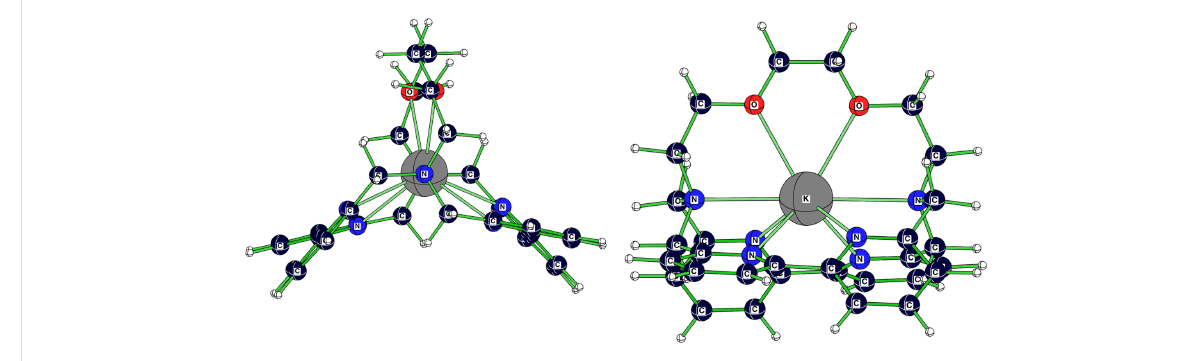
Figure 4: Calculated (RB3LYP/LANL2DZp) structure ( C 2 ) for [K 2.bpy.bpy] + .